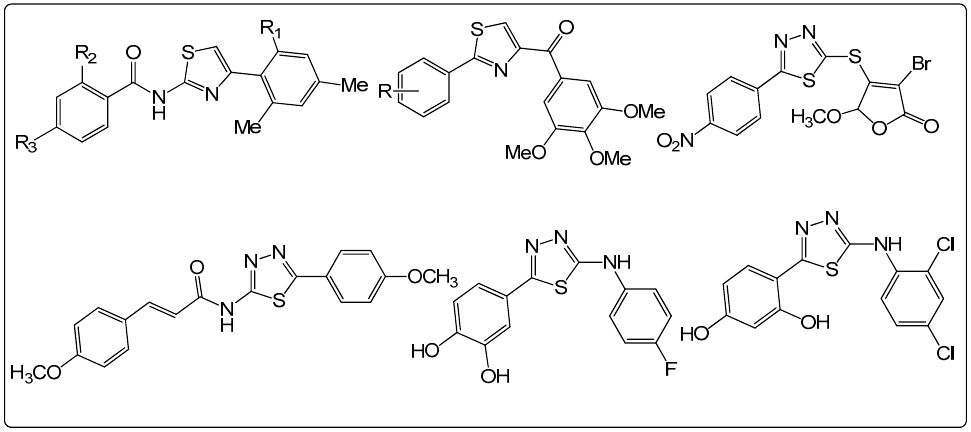
Figure 1. Lead compounds among thiazole and thiadiazole derivatives with anticancer